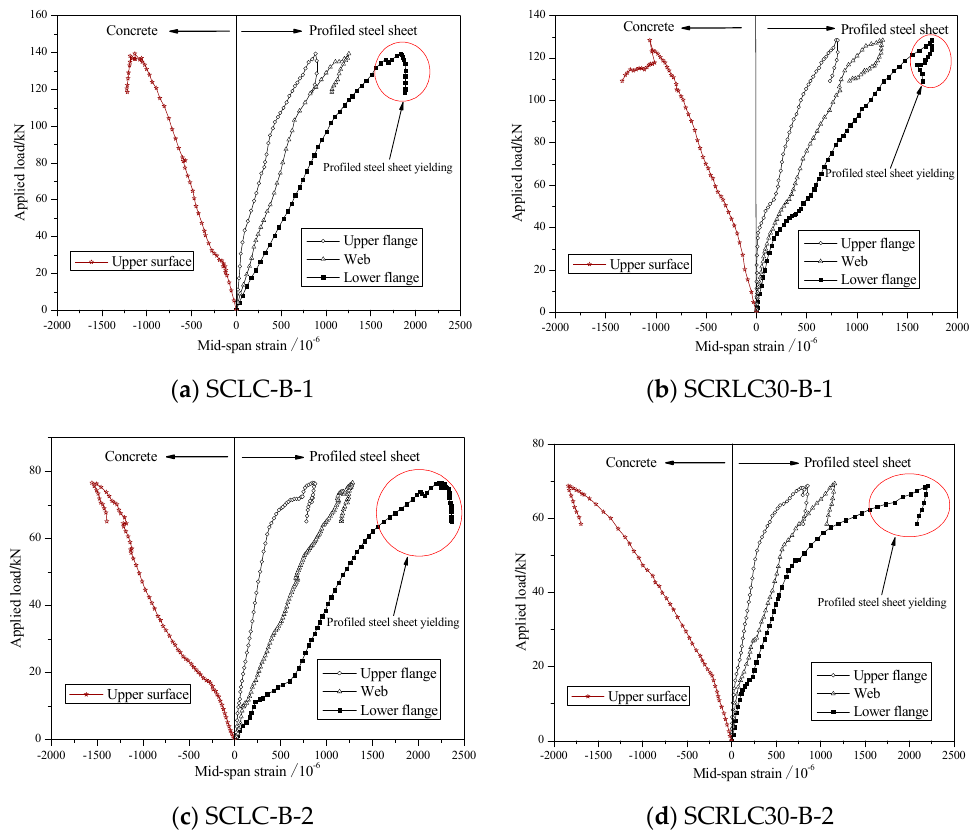
Figure 12. Load-profiled steel sheeting/concrete strain curves of different composite slabs at mid-span. ( a ) SCLC-B-1, ( b ) SCRLC30-B-1, ( c ) SCLC-B-2, ( d ) SCRLC30-B-2.